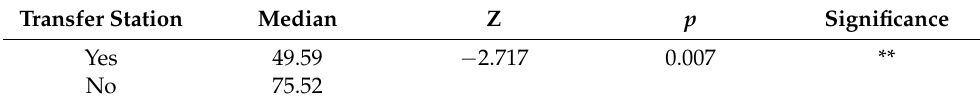
Table 6. Non-parametric test results for “transfer station”. Transfer Station